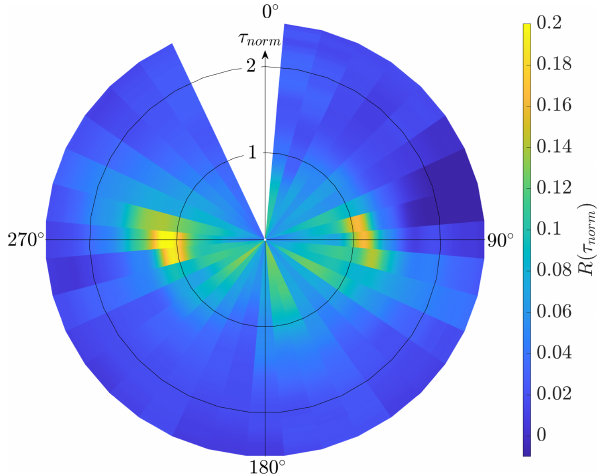
Figure 3. Average power output fluctuation correlation per 10 ◦ wind direction step of all available wind turbine pairs within the wind farm. Since the power output fluctuation correlation is aver- aged for wind direction intervals of 20 ◦ , the intervals overlap by 10 ◦ . For a better visibility the intervals are visualised in 10 ◦ steps only; i.e. for 90 ◦ the interval goes from 80 to 100 ◦ but is visualised from 85 to 95 ◦ . The radius of the circle is the time lag τ norm ; i.e. τ norm = 0 is in the origin, and τ norm = 1 is on the inner black circle. No data were available for the wind direction interval around 350 ◦ (see Fig. 2).